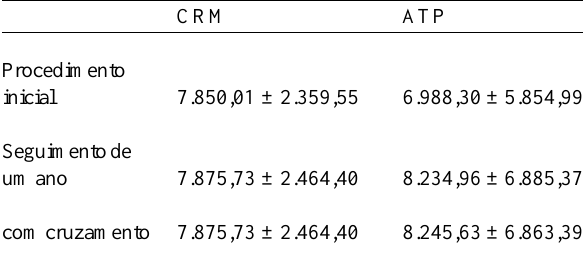
Tabela 3. Custos (R$), por paciente (procedimento inicial e seguimento por um ano).